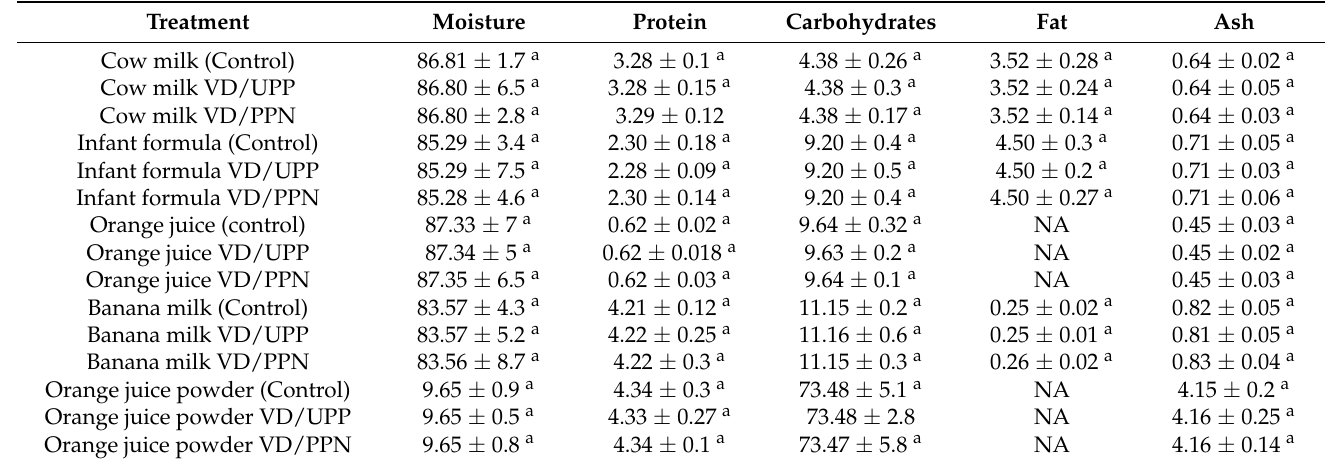
NA: not applicable. a Means within a column with the same letter are not significantly different ( p ≤